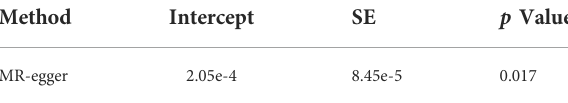
TABLE 4 Pleiotropy testing of instrumental variables for vitamin